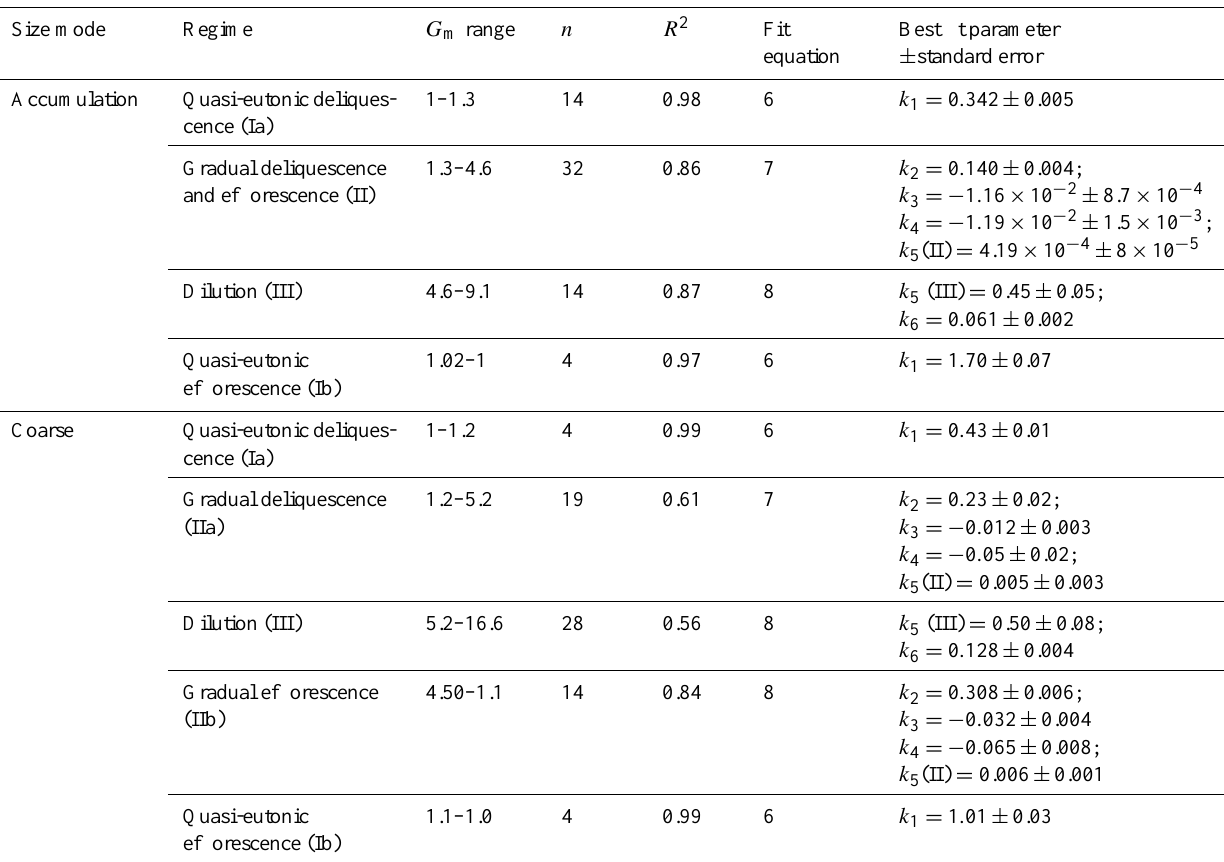
Table 3. KIM fit parameters for the accumulation (0.1–1µm) and coarse (>1µm) aerosol size modes collected at ZOTTO (Siberia); n and R 2 are the number of data points and the coefficient of determination of the